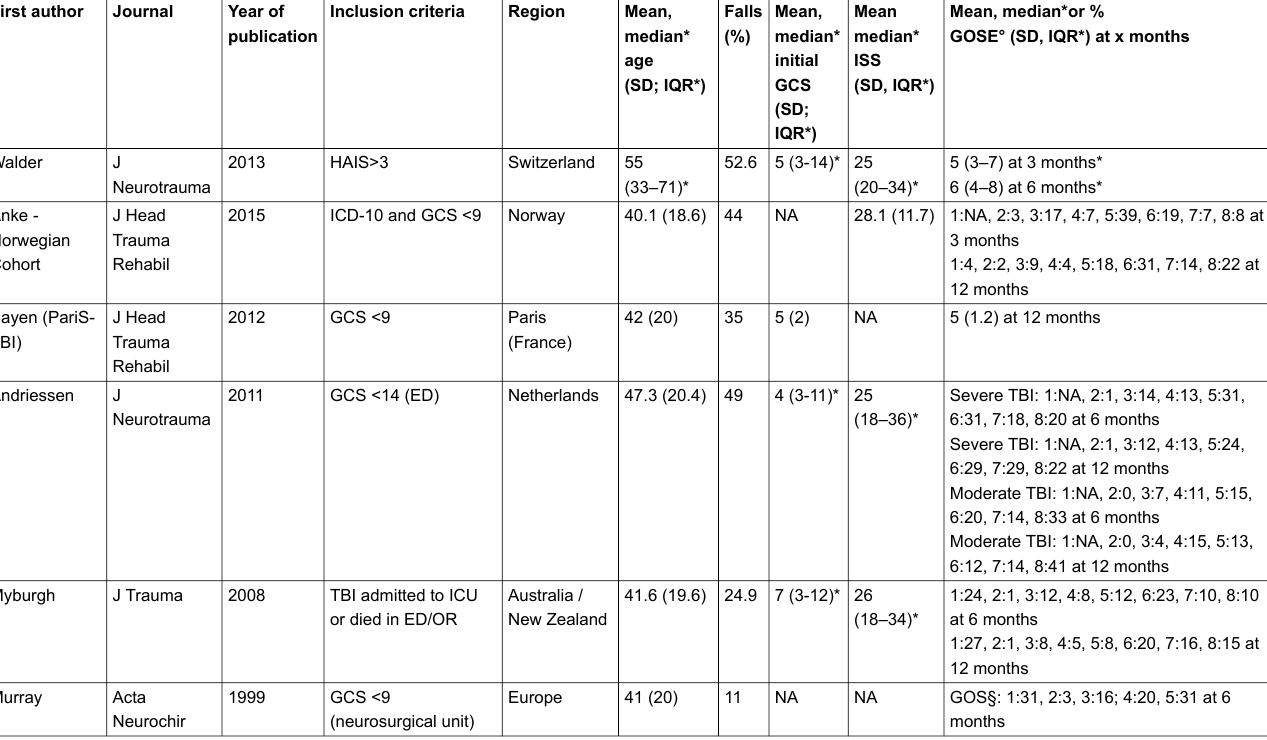
Table 4 : Large, multicentre cohort studies in high-income countries reporting on short-term disability of adults with severe traumatic brain injury. First